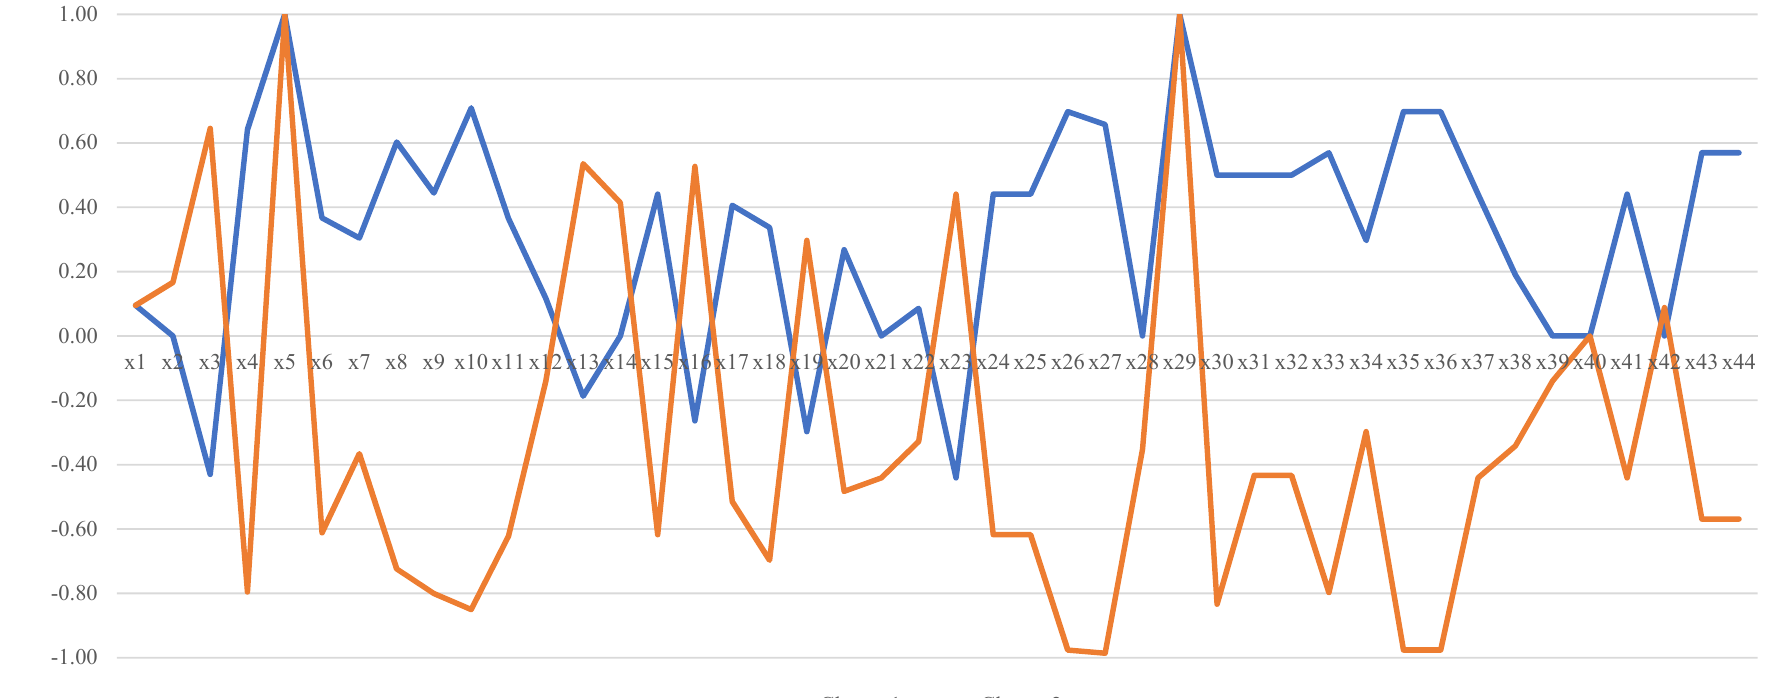
-1.00-0.80-0.60-0.40-0.200.000.200.400.600.801.00 Figure 3. Mean values of clusters for the classification of users of electric bicycles. Explanation as in Table 1. Source: own elaboration on the basis of the questionnaire survey.